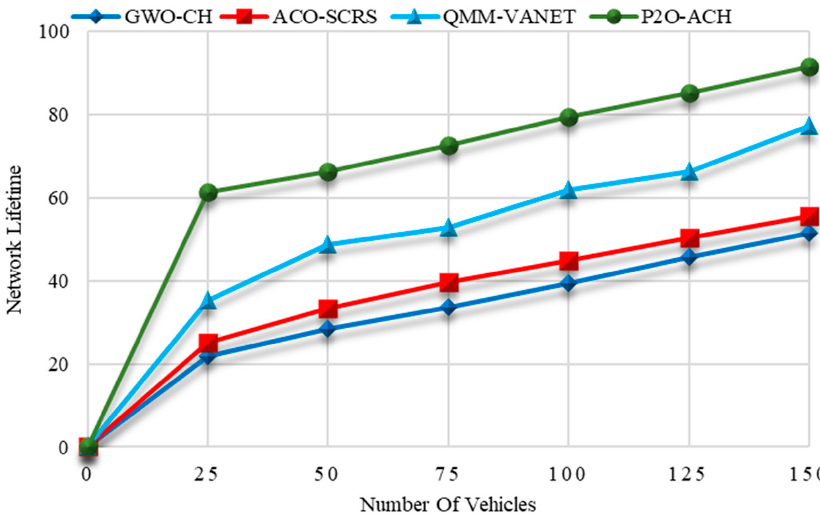
Figure 5. Network Lifetime Calculation.